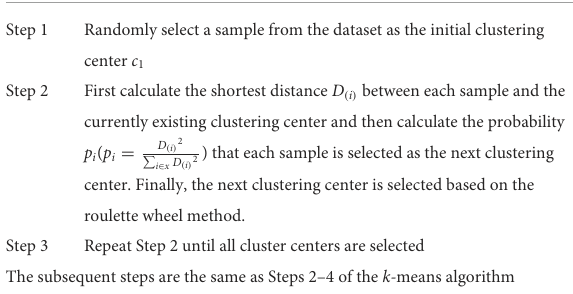
TABLE 2 k- means ++